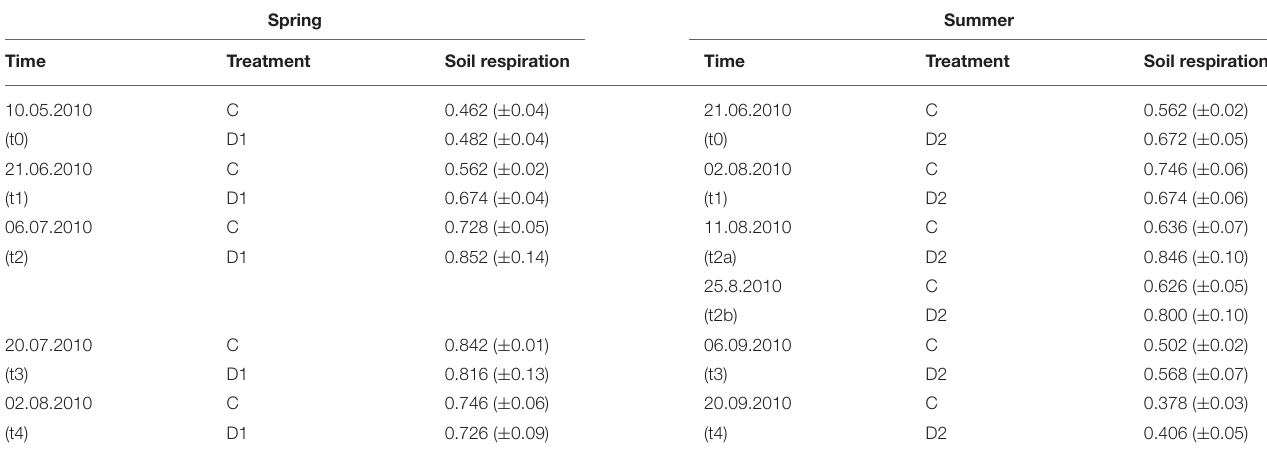
TABLE 2 | Soil respiration rates [g CO 2 m − 2 h − 1 ] of grassland in 2010 under different precipitation variabilities for spring drought (D1) and summer drought (D2); given are mean values and standard error of measuring dates, each n = 5; on 17th August soil respiration could not be monitored due to ambient rainfall, therefore, 11th August (t2a) and 25th August (t2b) were analyzed; no significant effects were